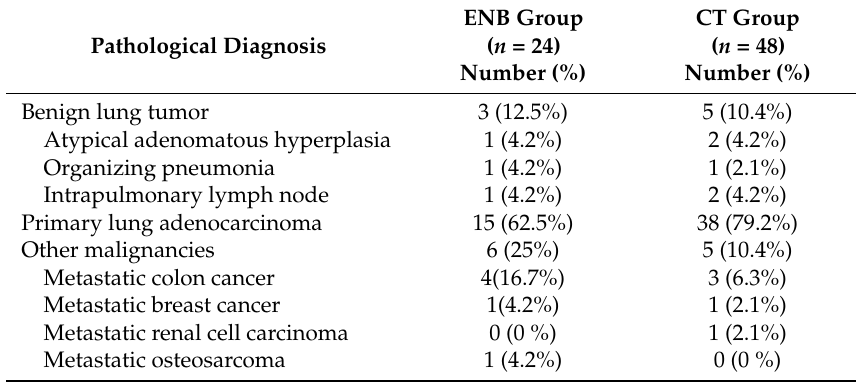
Table 2. Pathological diagnosis of lung